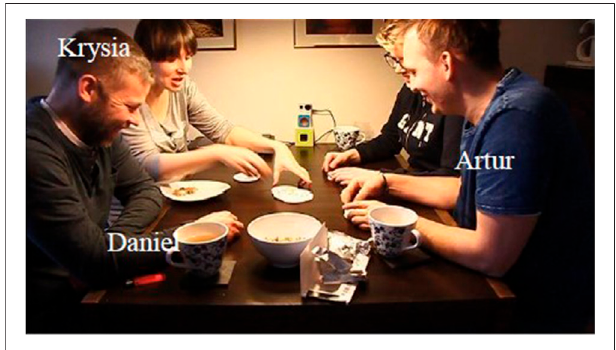
FIGURE 4 | Frames from Extract (9). Krysia adjusts the pile while formulating the impersonal TCU (line